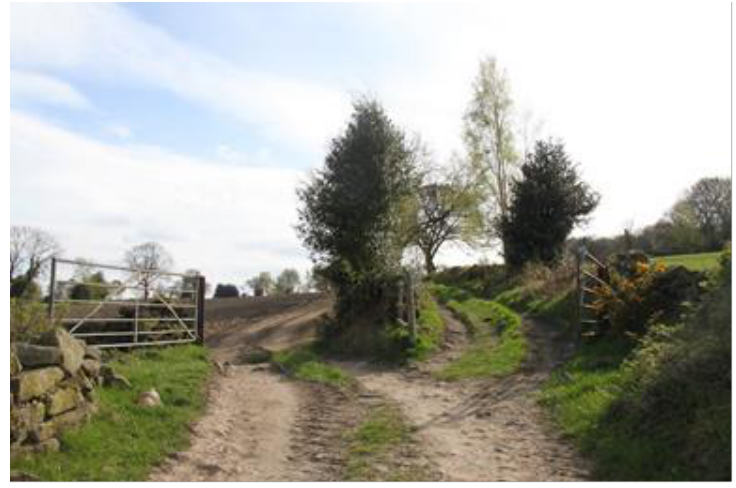
Figure 3. Farm track near South Wingfield.